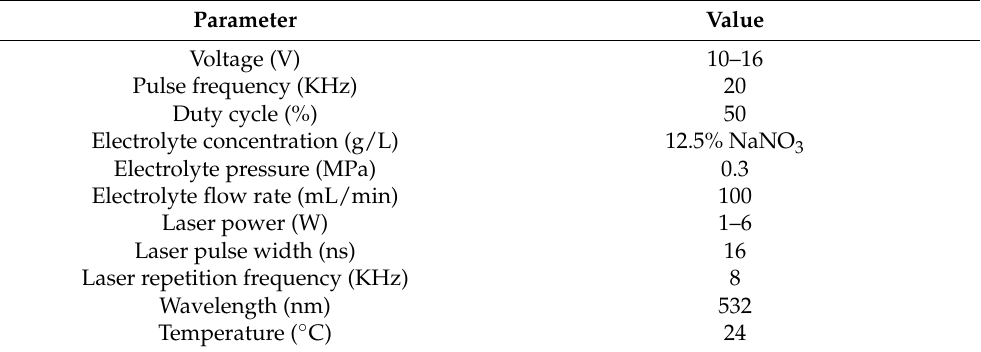
Table 1. Experimental conditions for hybrid laser and shaped tube electrochemical